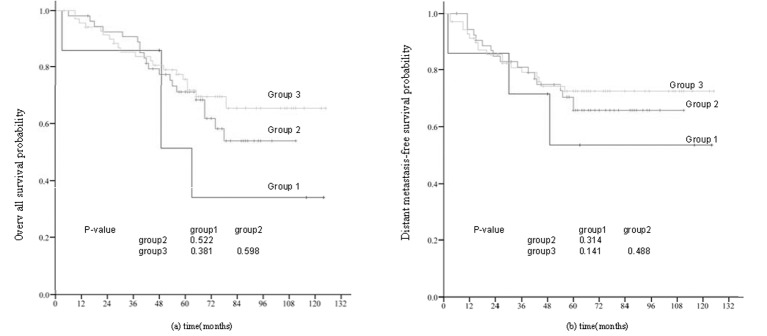
(a) Overall and (b) distant metastasis-free survival curves for 131 NPC patients with cavernoussinus invasion (CSI) stratified by chemotherapy regimen.Group 1: radiotherapy alone; Group 2: concurrent chemoradiation (CCRT); Group 3: neoadjuvant chemotherapy (NACT) + CCRT or NACT.